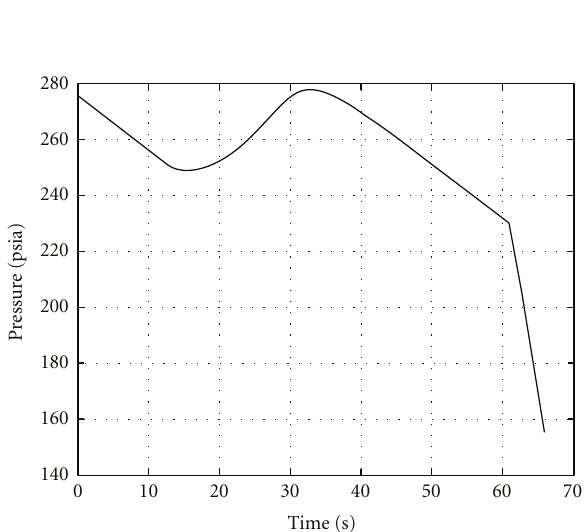
Figure 7: Desired regressive-progressive-regressive pressure-time curve.